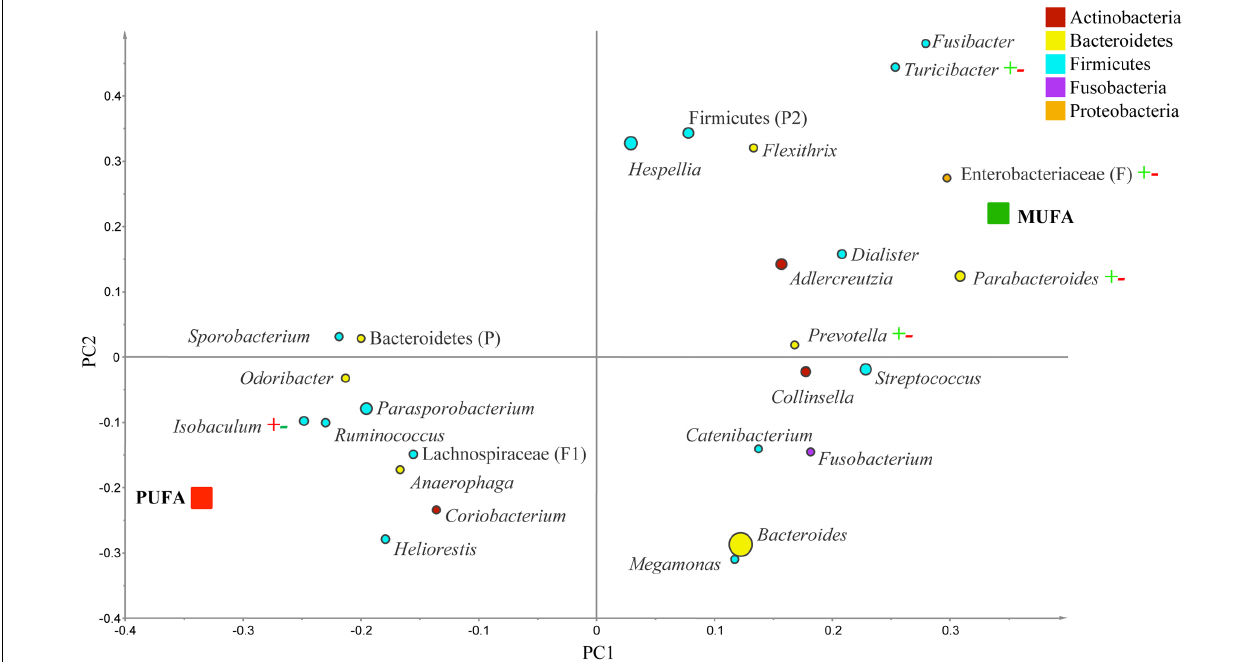
FIGURE 2 | Partial least square discriminant analysis (PLS-DA) loading plot based on the relative abundances of bacterial genera in the gut microbiota and their association with MUFA-rich or PUFA-rich diets. The presenting genera are chosen at VIP cutoff of 1.0 and colored according to their corresponding phyla. The size of circles is indicative of taxa abundance. Taxa closer to MUFA or PUFA indicate positive association with either treatment group. The R 2 ( = 0.43) and Q 2 ( = 0.07) estimates were calculated based on three components. While majority of sequences were identified at the genus level (G), some could only be affiliated to phylum (P), class (C), order (O), or family (F)